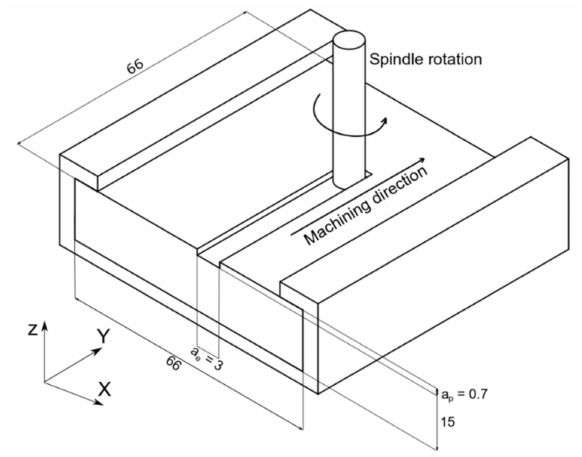
Figure 1. Schematic assembly for the slotting tests dimensions in